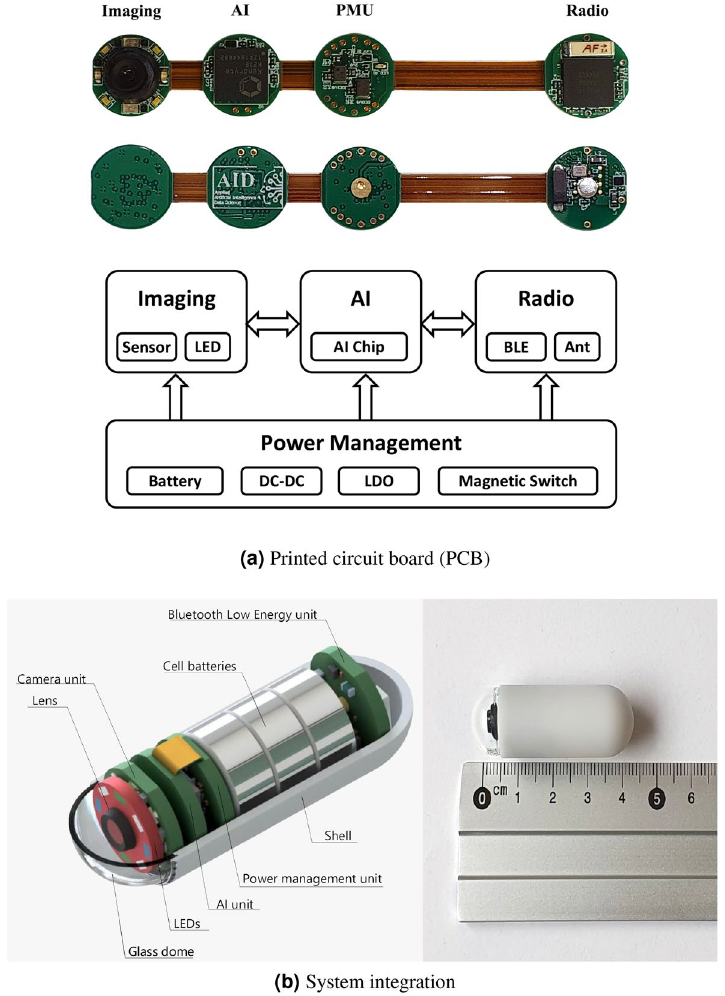
Figure 2. Camera pill’s PCB ( a ), system architecture of our camera pill ( b , left), and the prototype (designed in Autodesk Inventor 2021; https:// www. autod esk. com/ produ cts/ inven tor/ overv iew) and sealed components ( b ,